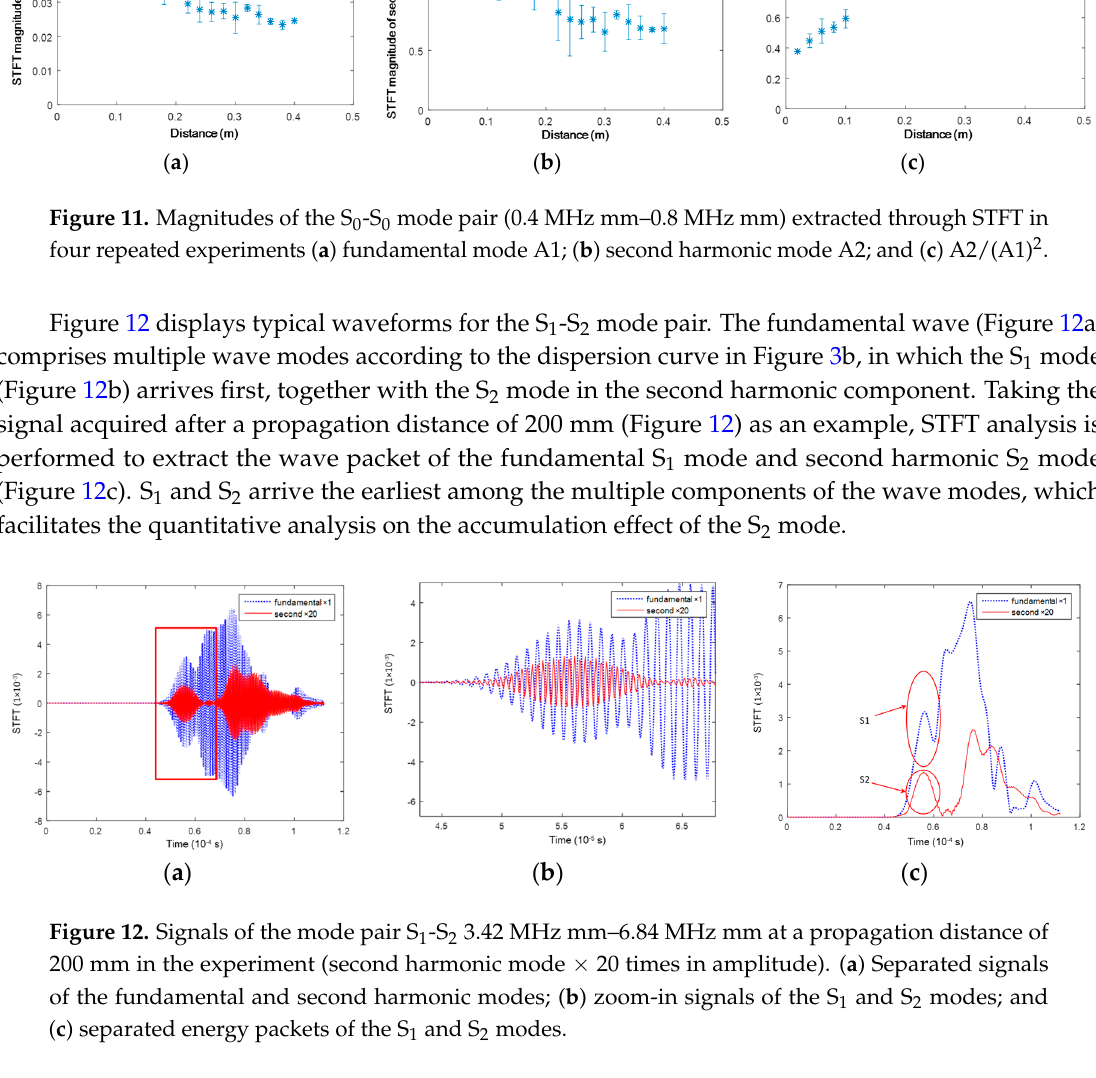
Figure 13. Magnitudes of the S 1 -S 2 mode pair (3.42 MHz mm–6.84 MHz mm) extracted through STFT in four repeated experiments. ( a ) Fundamental mode A1; ( b ) second harmonic mode A2; and ( c ) A2/(A1) 2 .